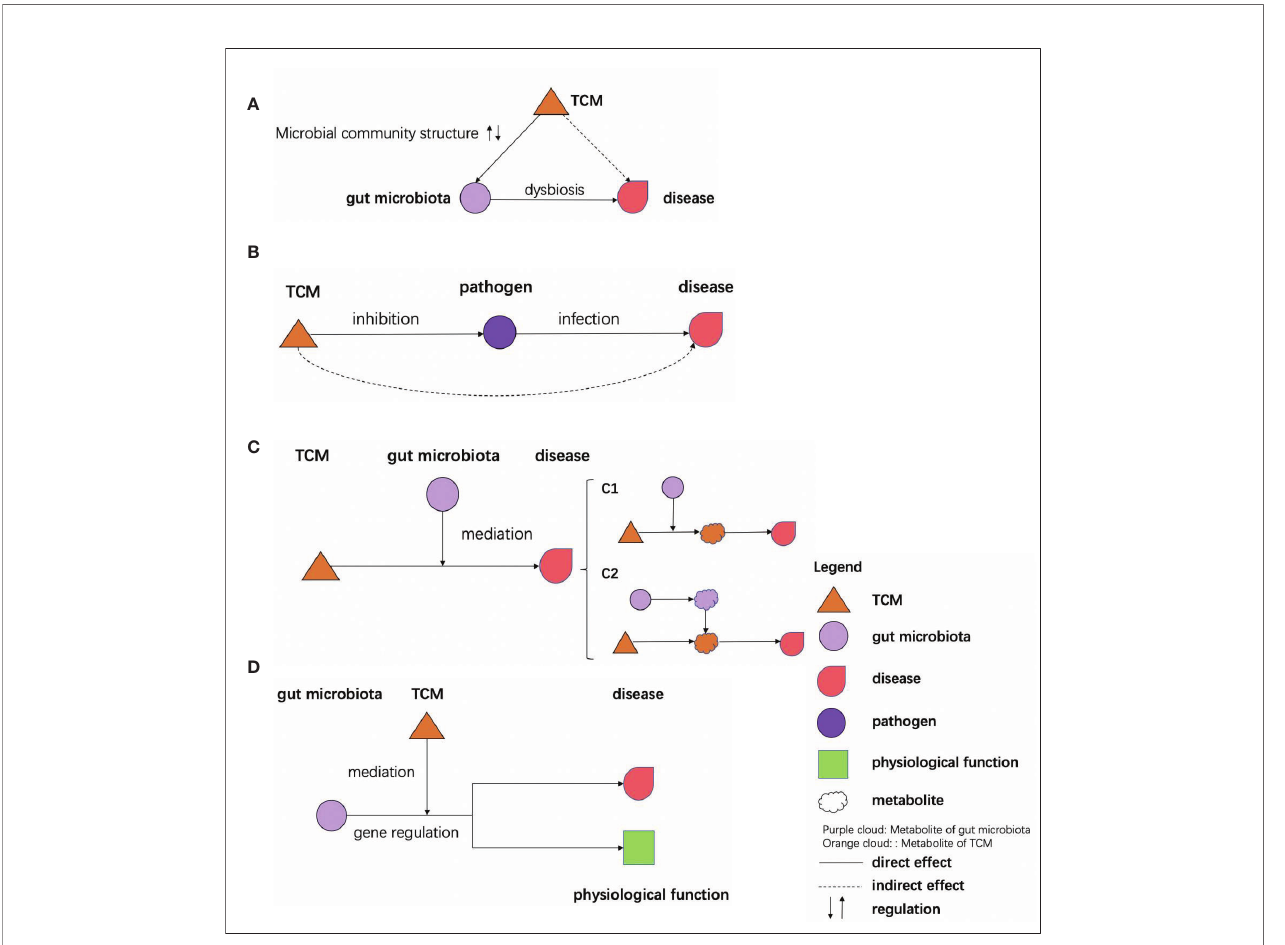
FIGURE 3 | Effects of TCM on microbiome. (A) TCM affects the gut microbiota to restore dysbiosis. (B) TCM inhibits the pathogen to prevent the infection. (C) The bioactive ingredients of TCM are mediated by the gut microbiota to exert their effects: (c1) the bioactive ingredients of TCM are mediated by the gut microbiota (c2) the bioactive ingredients of TCM, and the metabolites of the gut microbiota would react and effect genes. (D) The gut microbiota effects are mediated by the TCM through gene